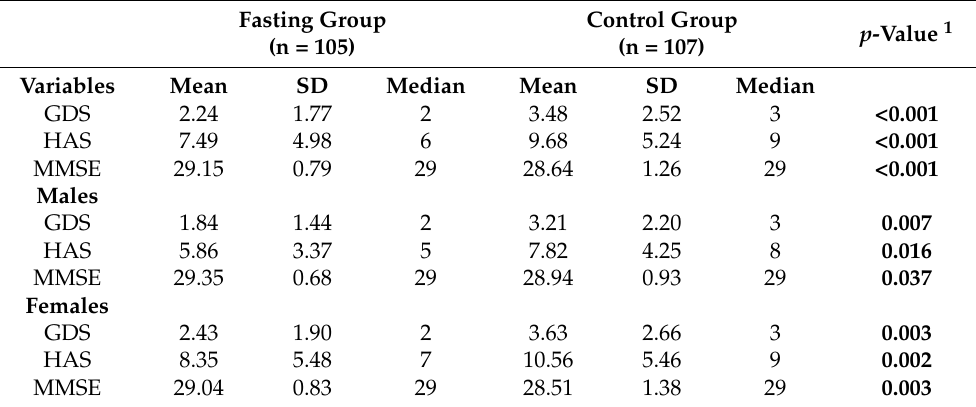
Table 3. Summary statistics for mental health variables by group and gender.